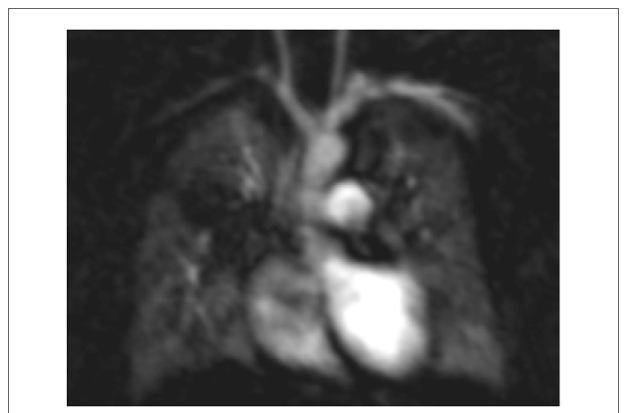
FigURe 6 | Magnetic resonance imaging angiogram in a child with bronchopulmonary dysplasia demonstrating poor perfusion of the right upper lobe related to severe small airways disease and reflex